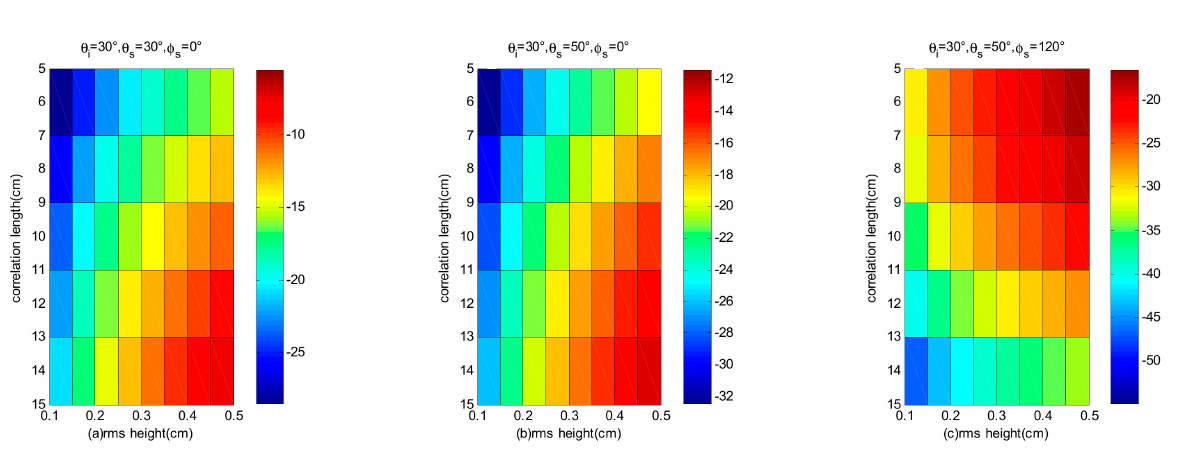
Figure 6. The effect of surface roughness (RMS height and cl (correlation length)) on the bi-static scattering under different observation geometries. The polarization is LR. ( a ) θ i = 30 o , θ s = 30 o , ϕ s = 0 o ; ( b ) θ i = 30 o , θ s = 50 o , ϕ s = 0 o ; ( c ) θ i = 30 o , θ s = 50 o , ϕ s = 120 o .